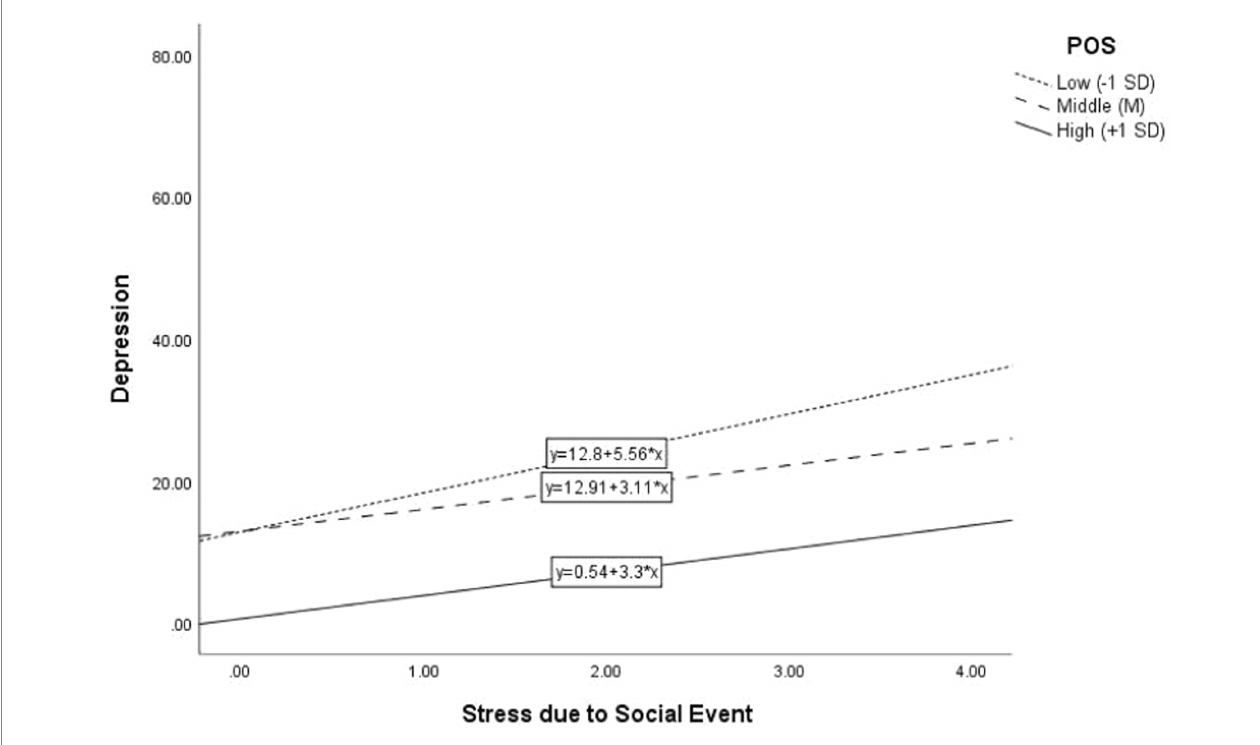
FIGURE 2 Moderating effect of composite positive psychological factors (POS) on the relationship between stress due to social event and